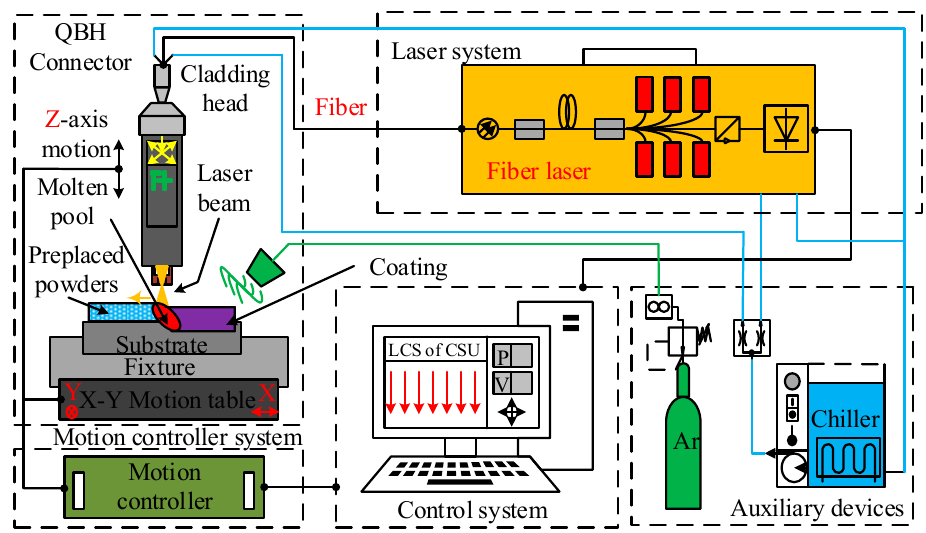
Figure 2. Schematic diagram of the laser cladding system.